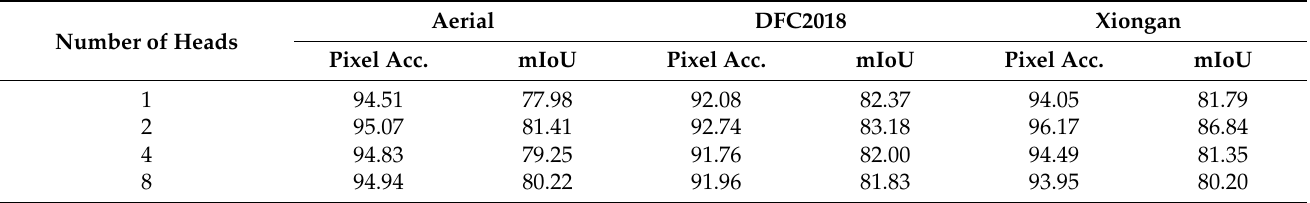
Table 9. Influence of the number of heads in MSA on the performance of CTAFNet.